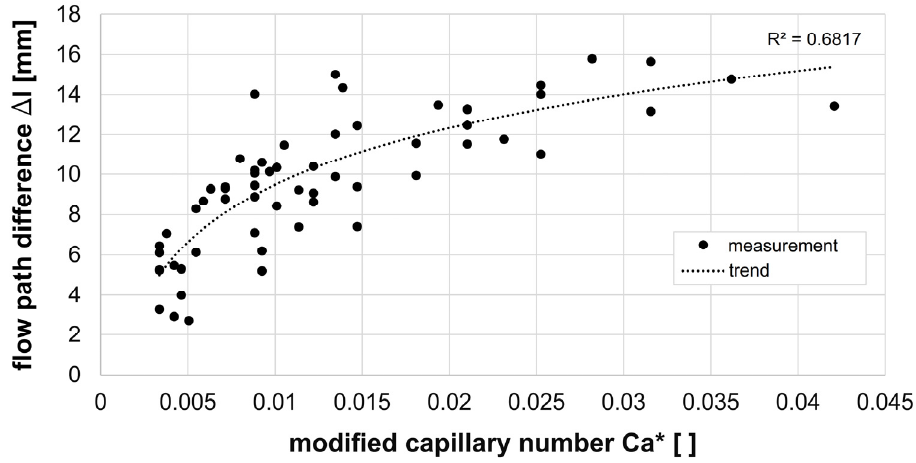
Figure 10. Trend of the flow path difference in coherence with the local modified capillary number.